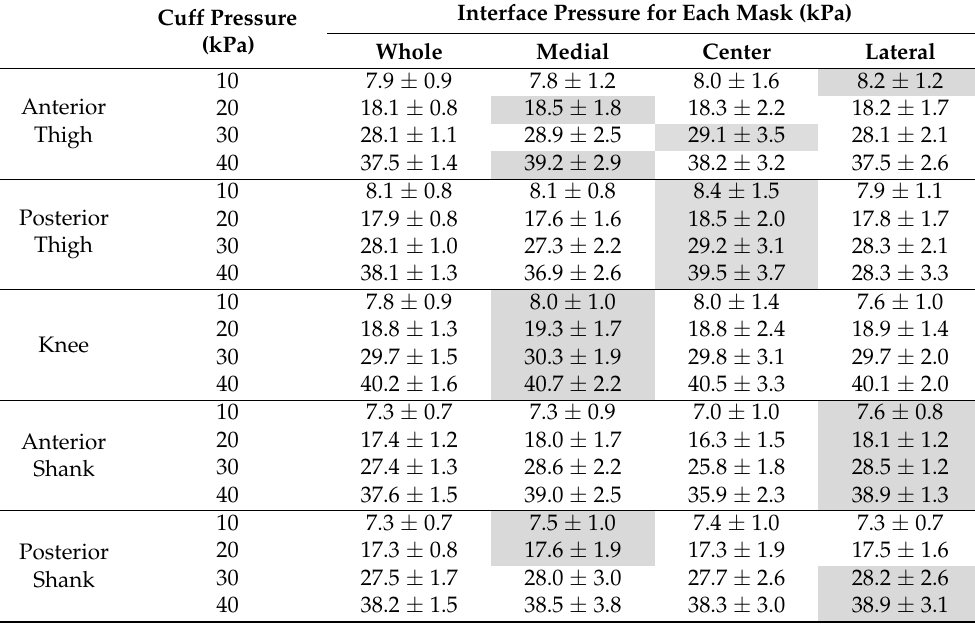
Figure 3. Musculoskeletal configurations of various binding parts and their pressure distributions. Pressure distributions correspond to the blue box in the 1 st row. The bottom two rows are examples of pressure distribution for 2 subjects out of 10 total. In the pressure distribution, red box represents the whole mask and sub-divided boxes represent medial, center, and lateral masks of interest. Table 1. Interface pressure for each mask.